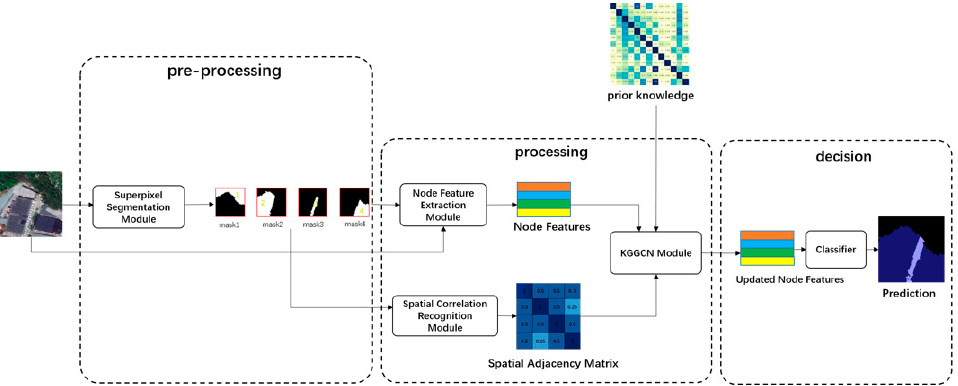
Figure 4. The structure of our approach. The input is the original image, and the output is the prediction.